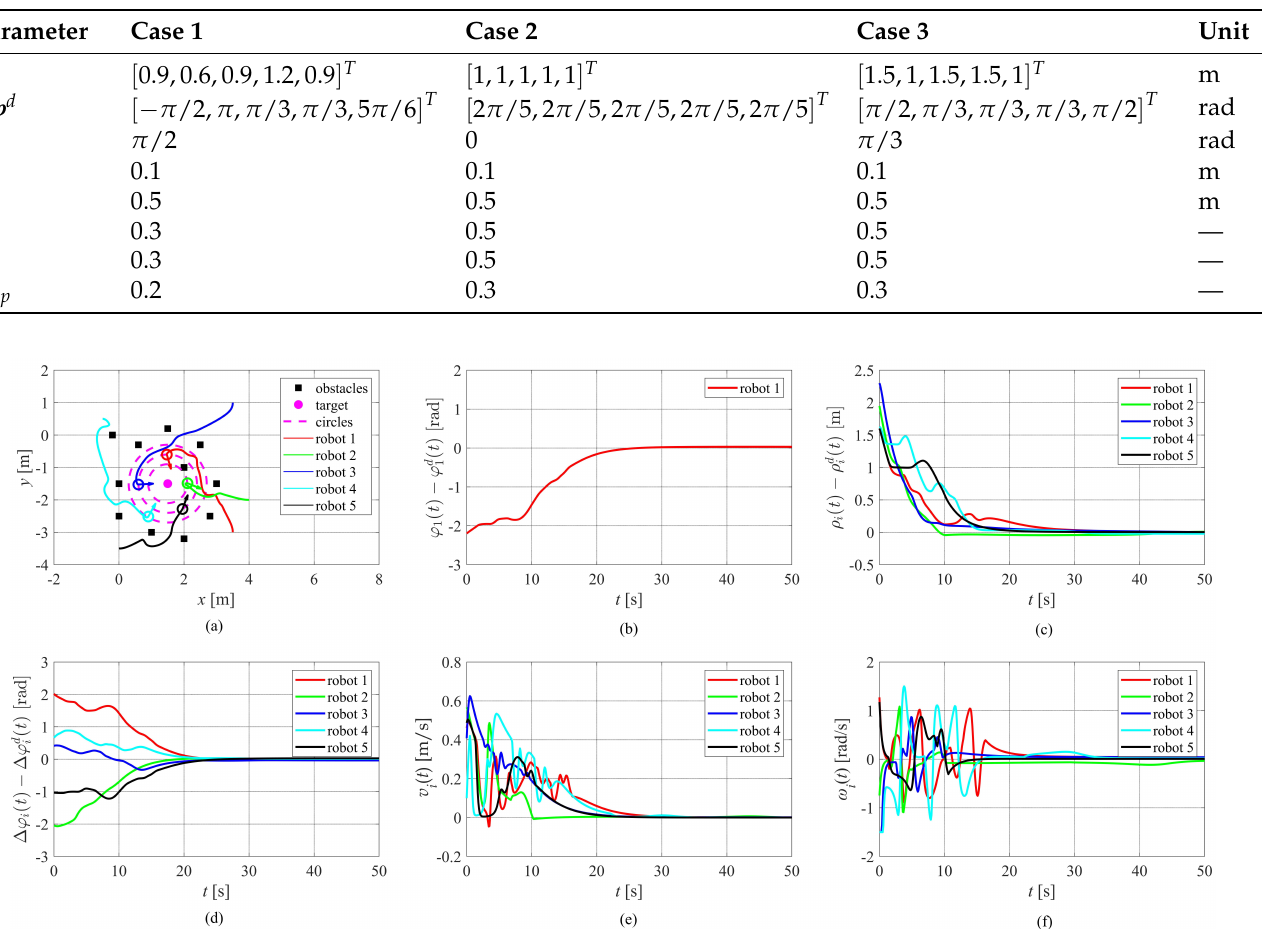
Table 1. The parameters of three groups of simulations.